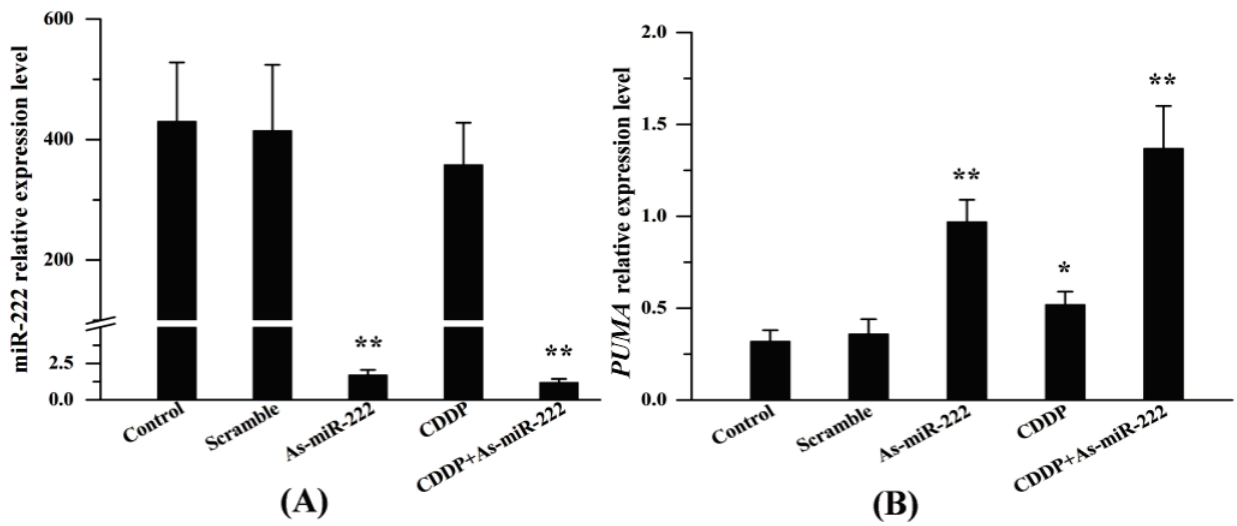
Figure 1. RT-PCR analysis of miR-222 and PUMA expression in UM1 cells treated with CDDP and As-miR-222 combination. ( A ) RT-PCR results showed significant down-regulation of miR-222 after transfection with As-miR-222 in UM1 cells; and ( B ) The expression of PUMA in CDDP, As-miR-222 and As-miR-222/CDDP groups was significantly up-regulated relative to that in the control and scramble groups. * Denotes statistical significance ( p < 0.05); ** denotes obvious statistical significance ( p <